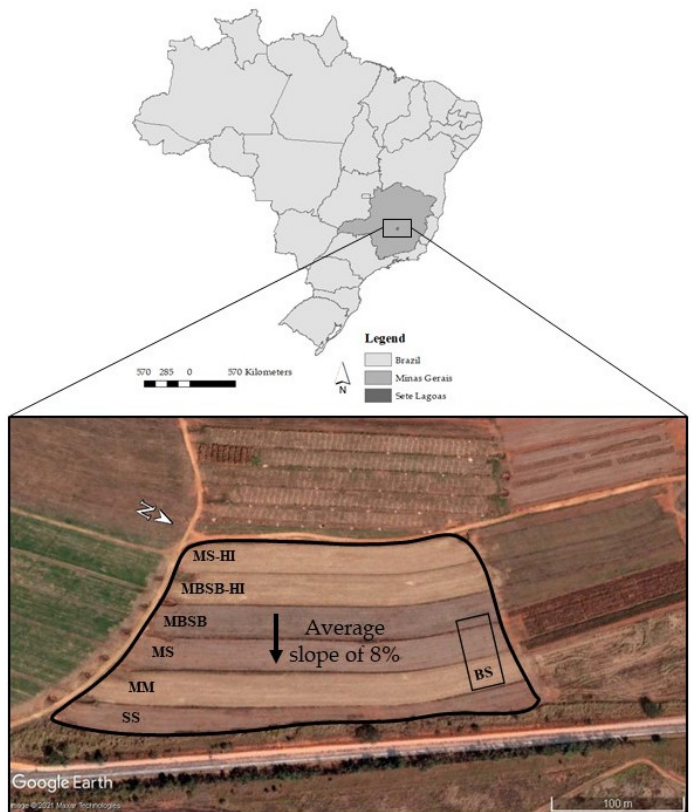
Figure 2. Aerial image of the experimental site in Sete Lagoas, central region of the state of Minas Gerais, Brazil. SS = soybean monoculture, MM = maize monoculture, MS = maize/soybean annual rotation, MBSB = maize/brachiaria/soybean/brachiaria rotation, BS = bare soil, and HI = high input of fertilizers.